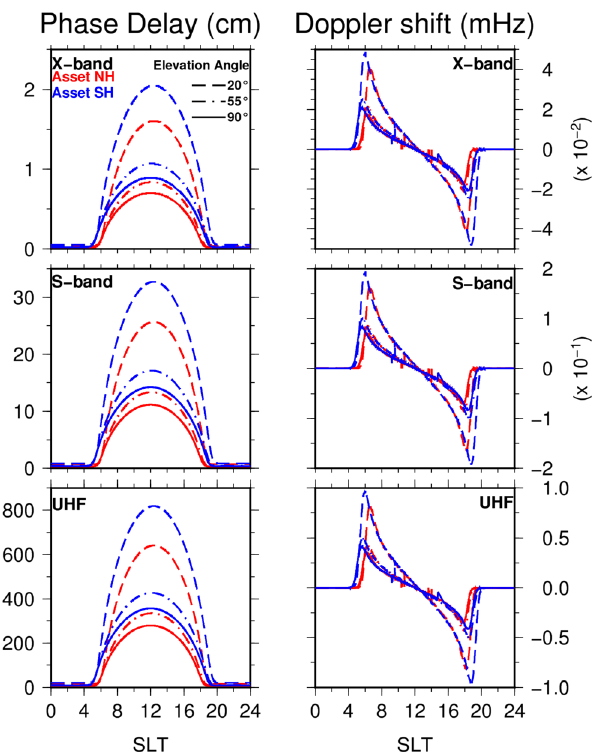
Fig. 10. Effect of the Mars ’ ionosphere on radio wave propagation. Effect on UHF (0.4 GHz, bottom), S-band (2 GHz, middle) and X-band (8 GHz, top) radio signals. Left: effect on phase delay in centimetres; Right: impact on instant Doppler shift in mHz (assuming d t = 1 s). The red curves correspond to an asset situated in the Northern Hemisphere (E0 (cid:3) , N10 (cid:3) ) while the blue curves correspond to the one situated in the Southern Hemisphere (E0 (cid:3) , S10 (cid:3) ). The bold, dashed-dots and dashed lines correspond to a LOS elevation of 90 (cid:3) , 55 (cid:3) and 20 (cid:3) respectively (see e the elevation on Fig. 9). The solar activity level is fi xed at F10.7P = 120 sfu (moderate solar activity, see Fig. 1).